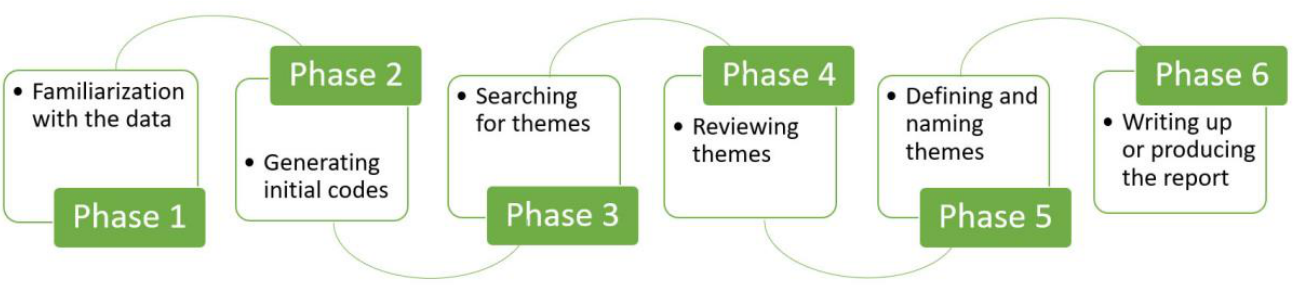
qualitative data results to combine the analytic narrative and extracted data by